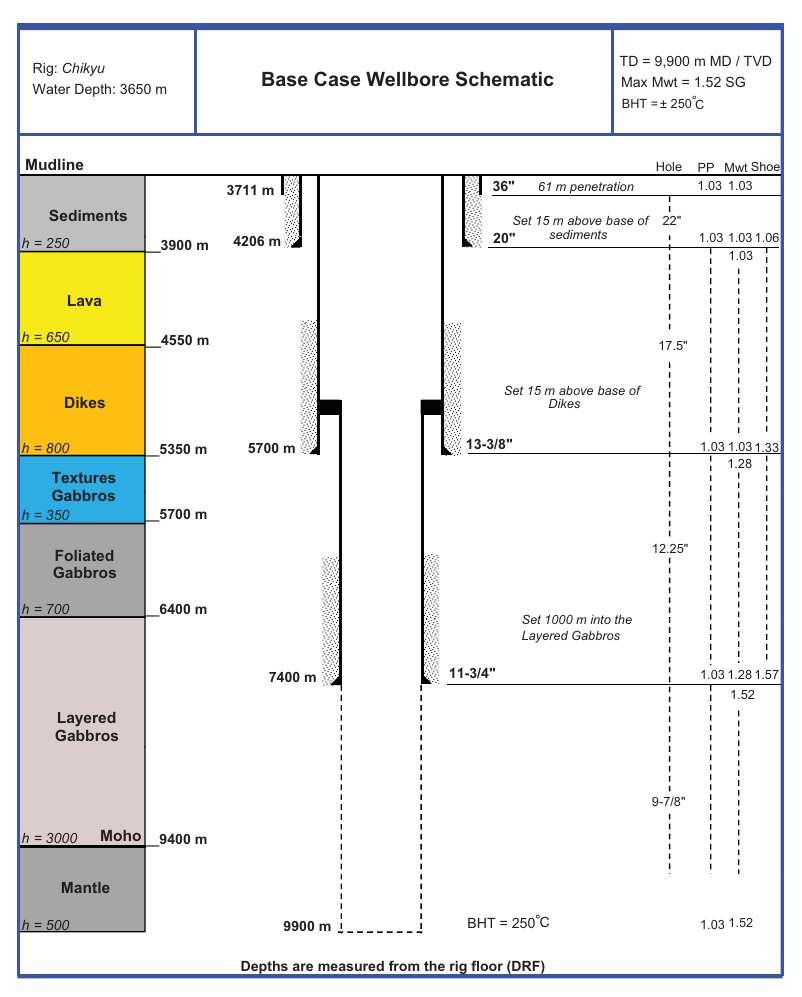
Figure 3. Base case wellbore